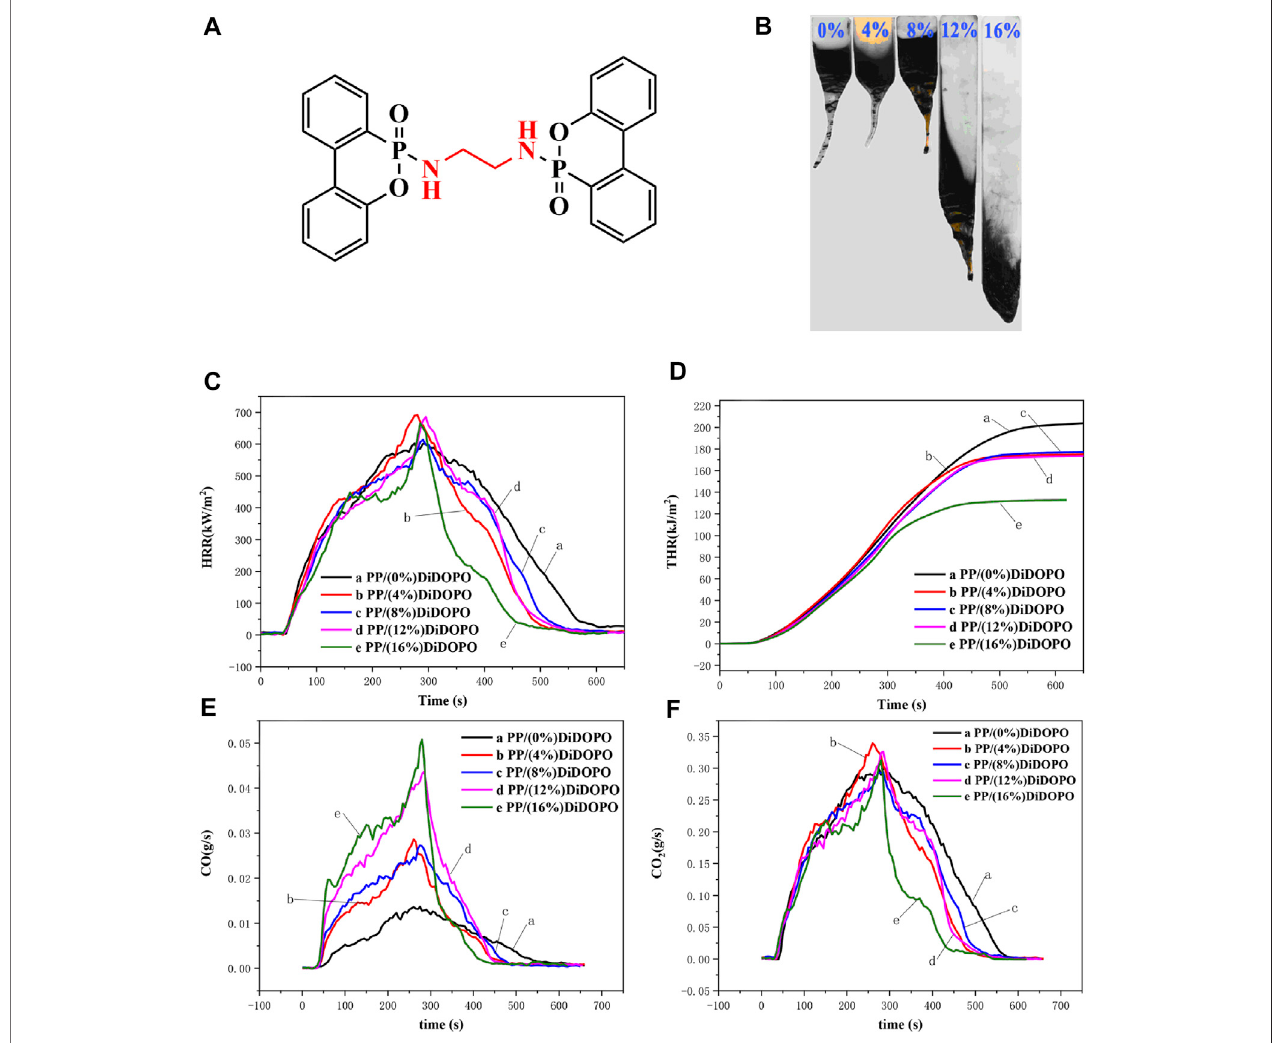
FIGURE 1 | the DiDOPO fl ame retardant with conjugated structure (A) , Photos of samples after UL-94 test (B) and HRR (C) , THR (D) , CO (E) , and CO 2 (F) yield curves of pure PP and each component PP/DiDOPO conjugated fl ame retardant composites.